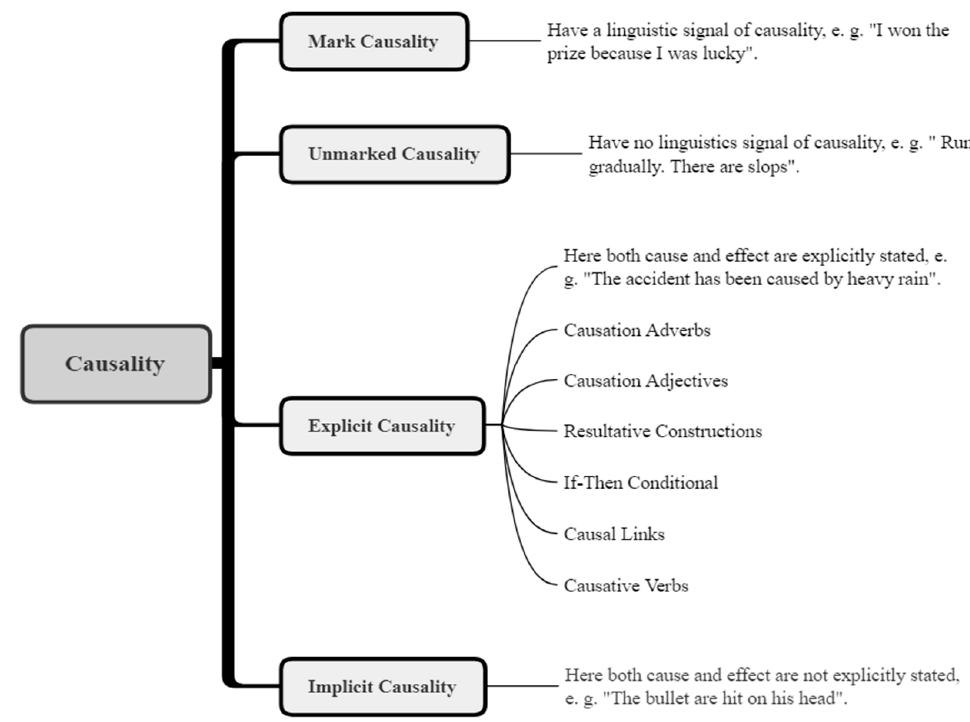
Figure 1. Representation of causality in the natural languages.